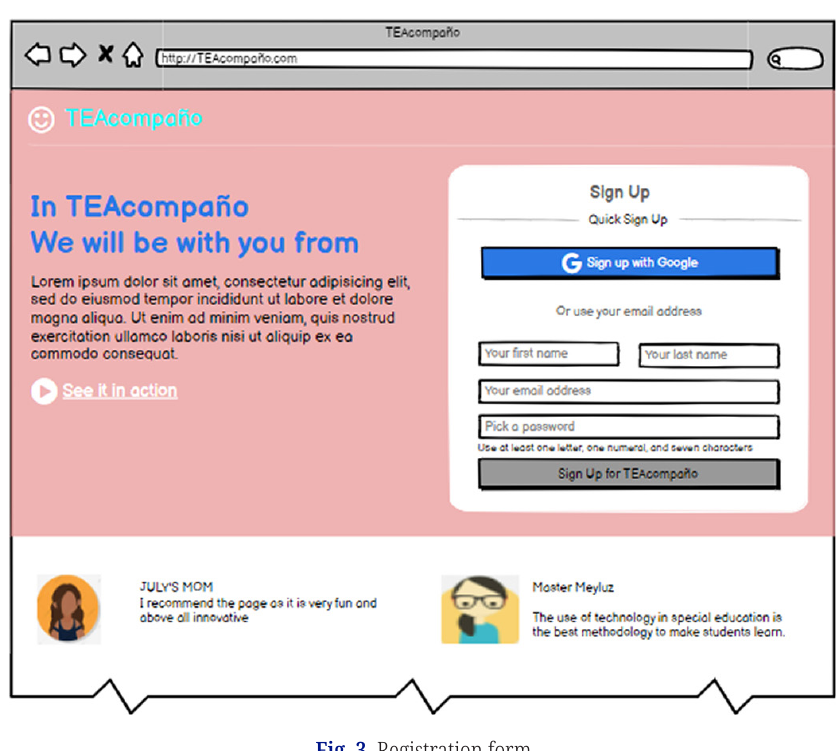
Fig. 3. Registration